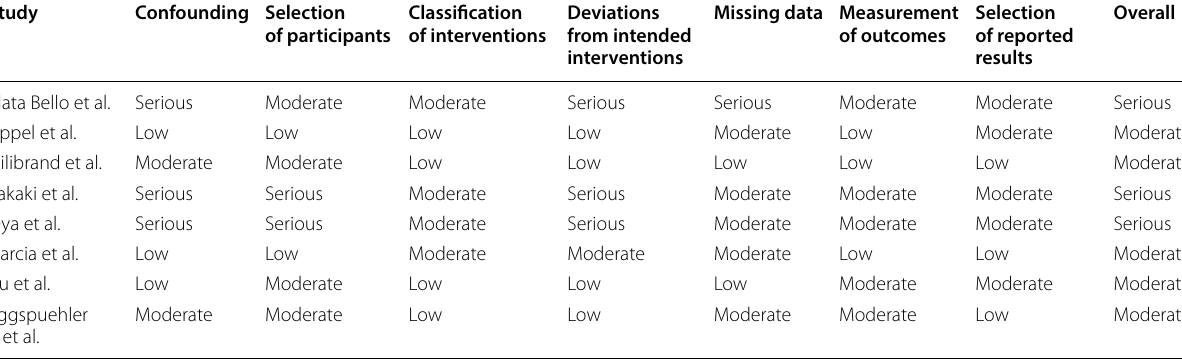
Table 2 Risk of Bias Judgements in Nonrandomized Studies of Interventions (ROBINS-I) evaluations Study